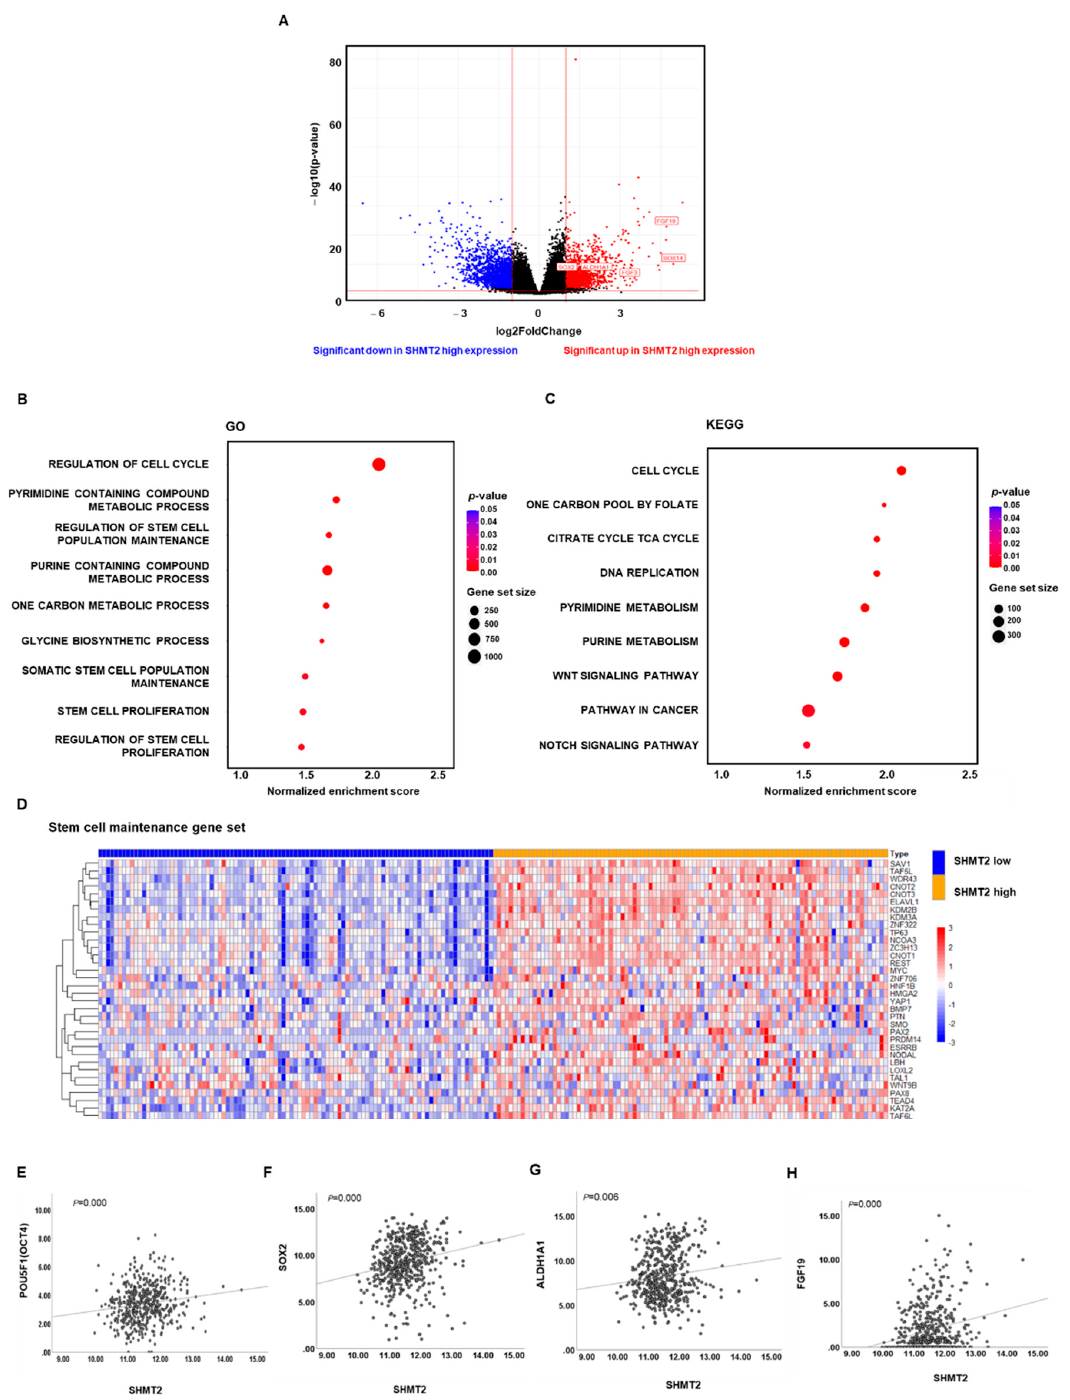
Figure 3. GO and KEGG enrichment analyses of DEGs between the low and high SHMT2 in the TCGA HNC cohort. Genes with |log2Fold Change|> 1 and a p -value < 0.01 were defined as differentially expressed genes (DEGs). The up-regulated genes are marked in red, and the down-regulated genes are marked in blue. ( A ) Volcano plot of DEGs. ( B , C ) GO enrichment and KEGG pathway analysis results for DEGs. ( D ) The GSEA heat map shows differences in the expression of the core enrichment genes involved in the stem cell maintenance gene set between the patients with high and low SHMT2 expression. ( E ) Correlation between POU5F1 ( OCT4 ) and SHMT2 , ( F ) Correlation between SOX2 and SHMT2 , ( G ) Correlation between ALDH1A1 and SHMT2 , and ( H ) Correlation between FGF19 and SHMT2 . Differences were considered relevant at p < 0.05.